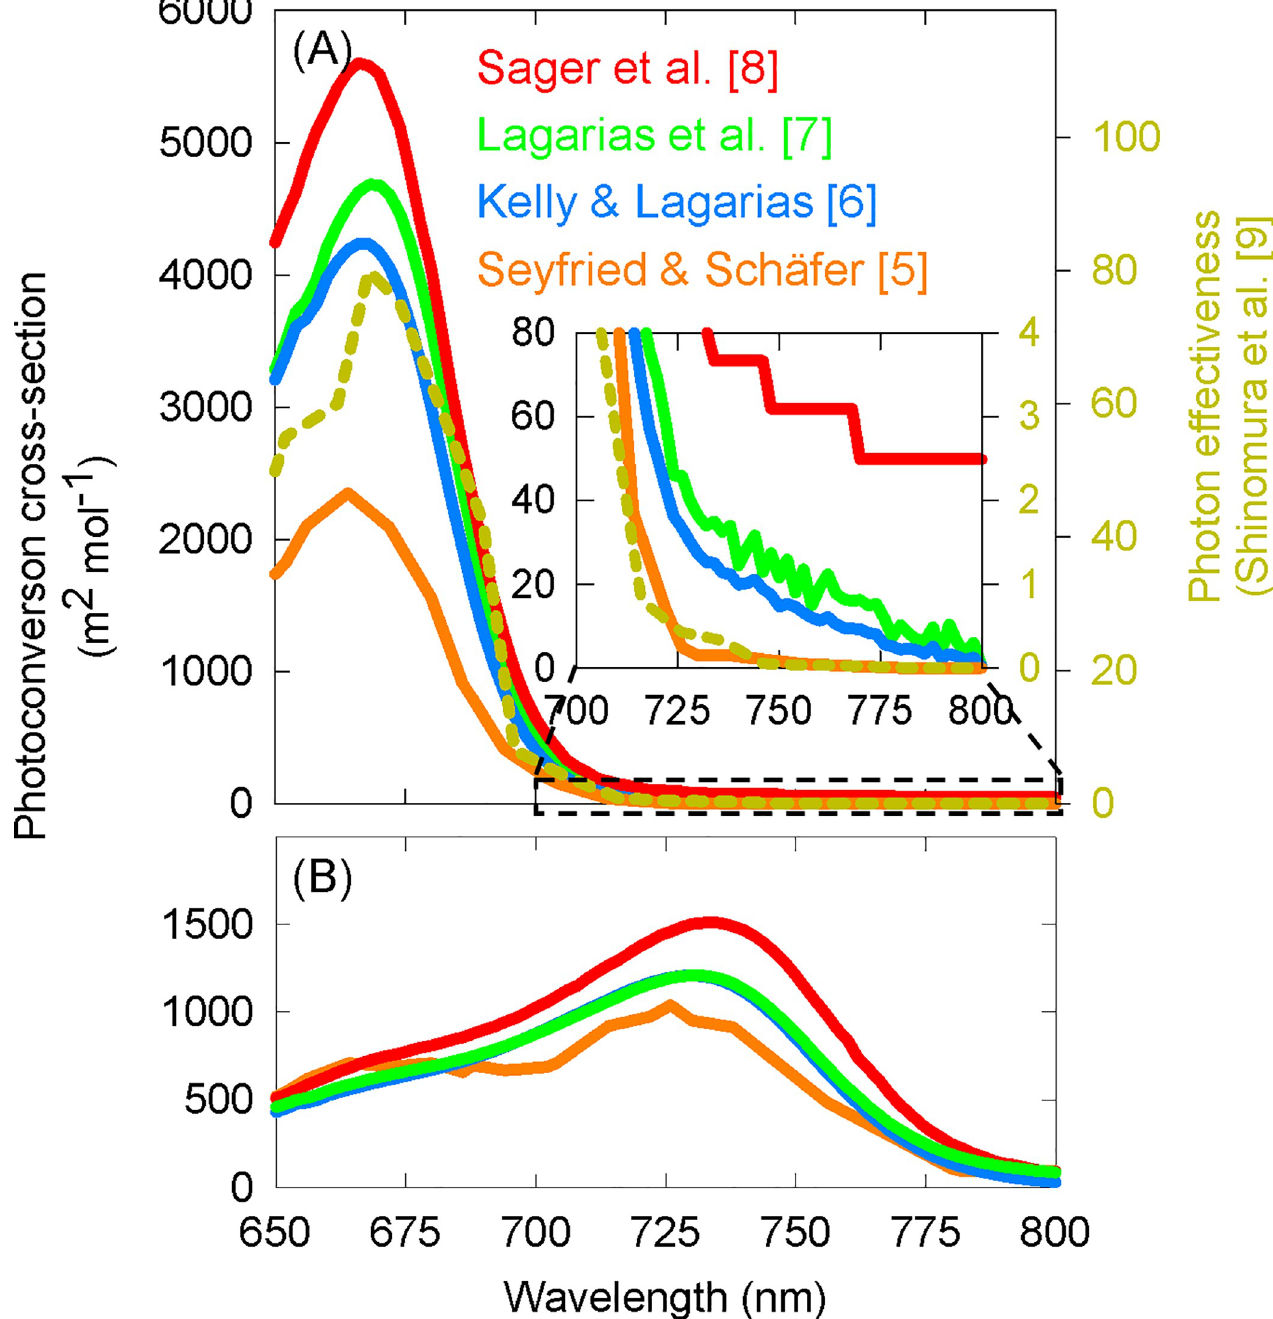
Fig 1. (A) Left axis, photoconversion cross-sections of P r determined by Seyfried and Scha¨fer [5], Kelly and Lagarias [6], Lagarias et al. [7] and Sager et al. [8]. Photoconversion cross-sections are related to absorbance spectra. Right axis, action spectrum of seed germination (dashed line) [9]. Inset: P r photoconversion cross-section between 700 to 800 nm. Note the inconsistency of P r action above 750 nm determined by different research groups. (B) Photoconversion cross- sections of P fr